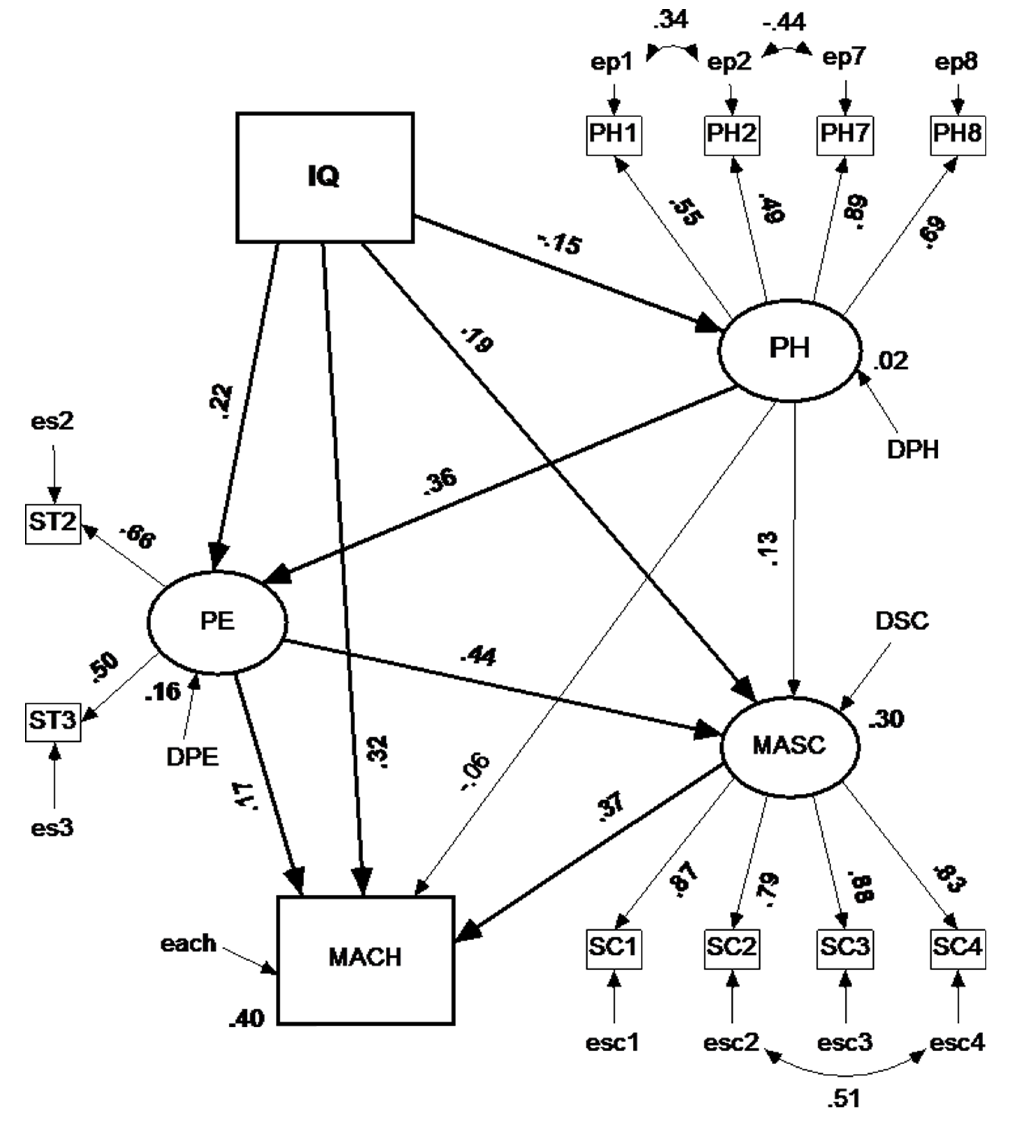
Figure 1. Structural model of simultaneous gender